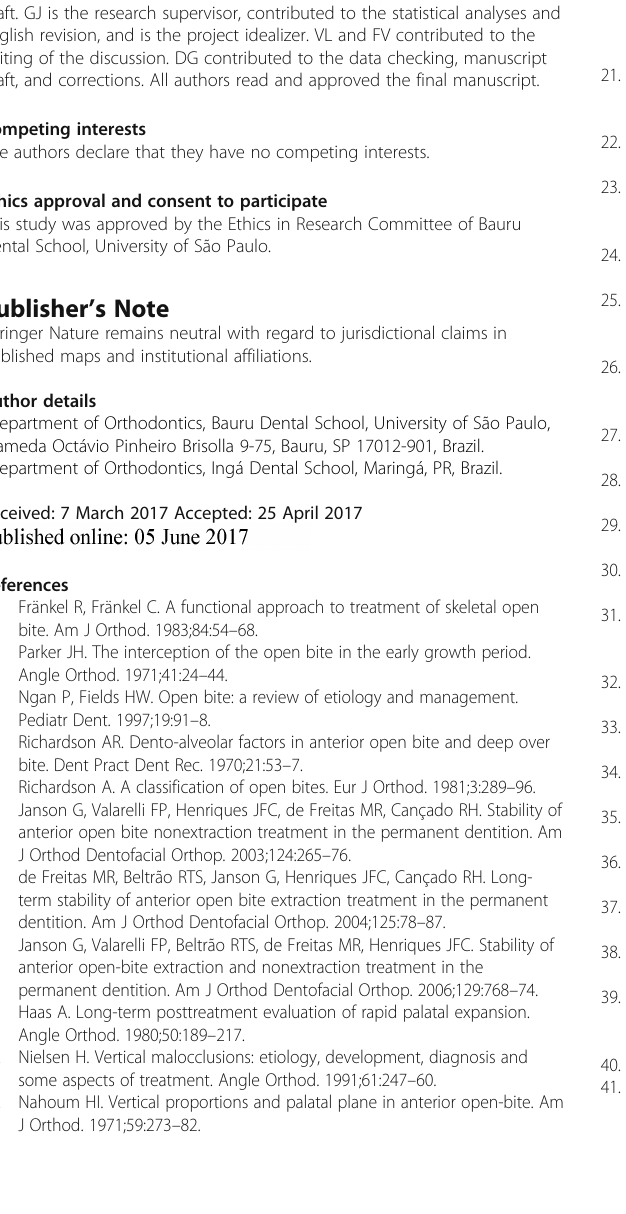
(cid:1) Correction of anterior open bite with either non- extraction or extractions with continuous archwires and vertical anterior elastics uprights the mandibular posterior teeth. (cid:1) However, there is also mesial angulation of the maxillary posterior teeth with this mechanics. (cid:1) Therefore, additional mechanical procedures should be used to increase posterior teeth uprighting in open-bite treatment, especially in the maxillary